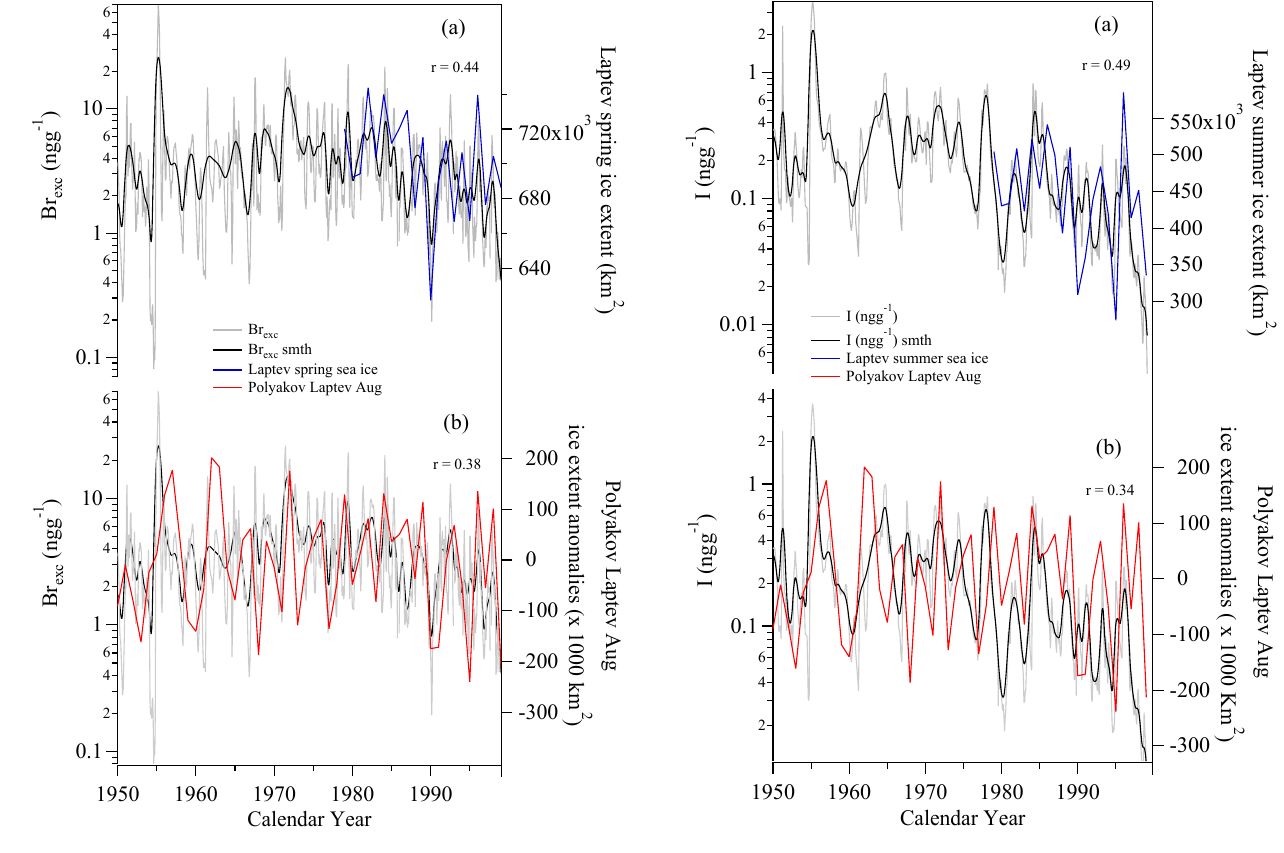
Figure 7. Br exc compared with sea ice area during spring and sum- mer in the Laptev Sea region. In both panels, raw (grey line) and 3-year smoothed (black line) Br exc data from the Akademii Nauk ice core are shown. The Laptev Sea spring sea ice data are based on satellite observations (blue line, a ). Laptev Sea summer sea ice anomalies (red line, b ) are from Polyakov et al. (2003).